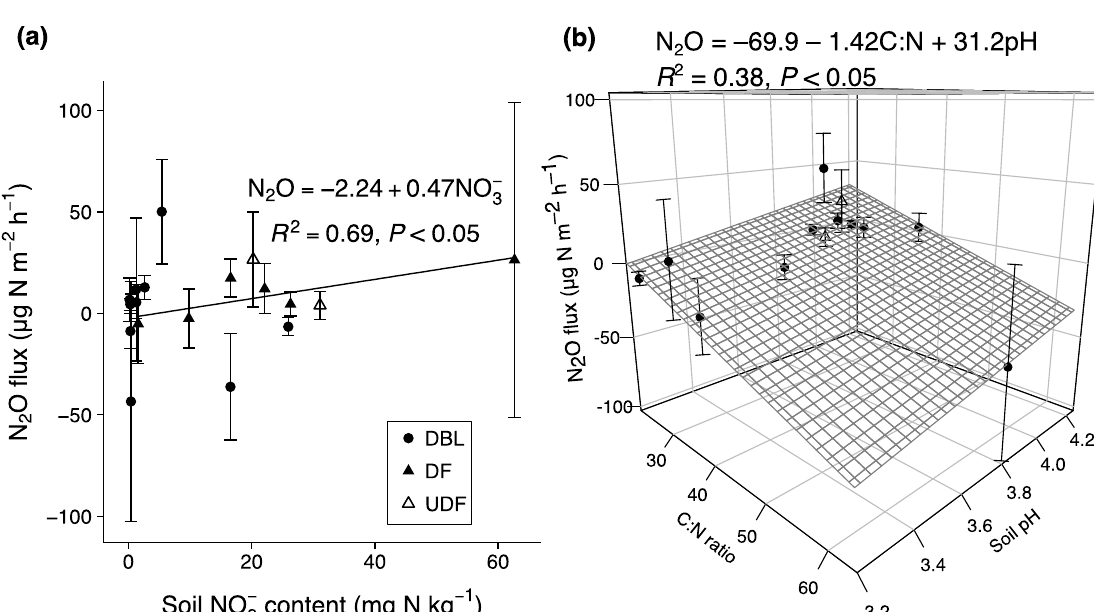
Figure 5. Relationship of N 2 O flux with ( a ) soil nitrate content in all land uses, and ( b ) soil C:N ratio and pH in undrained forest (UDF) and drained burned land (DBL). Error bars show ± 1 SD. The regression line in ( a ) is obtained from the data in drained forest (DF) only. The meshed surface in ( b ) show the result of multiple regression using data in UDF and DBL.